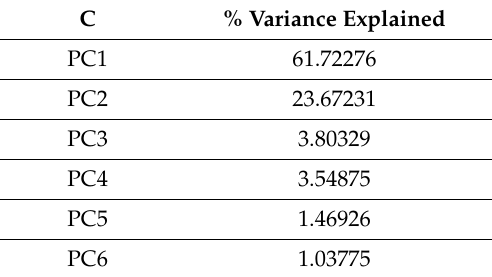
Table A1. The PCs with explained variance >